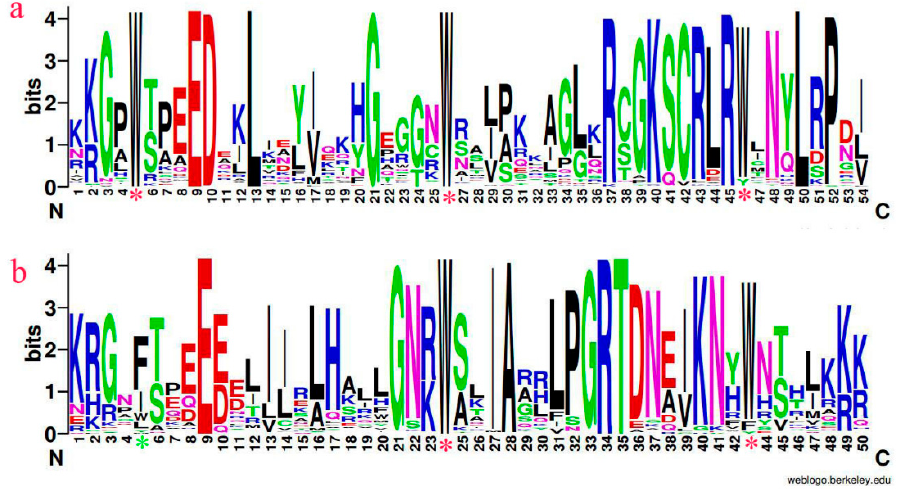
Figure 1. The sequence logos of R2 ( a ) and R3 ( b ) repeats are distributed in all R2R3-MYB proteins of the Vernicia species. The analysis of conserved domains of the R2 and R3 MYB sequences are based full-length alignments of VfR2R3-MYB and VmR2R3-MYB proteins in MEME Suite version on all the full-length alignments of Vf R2R3-MYB and Vm R2R3-MYB proteins in MEME Suite version 4.10.0.